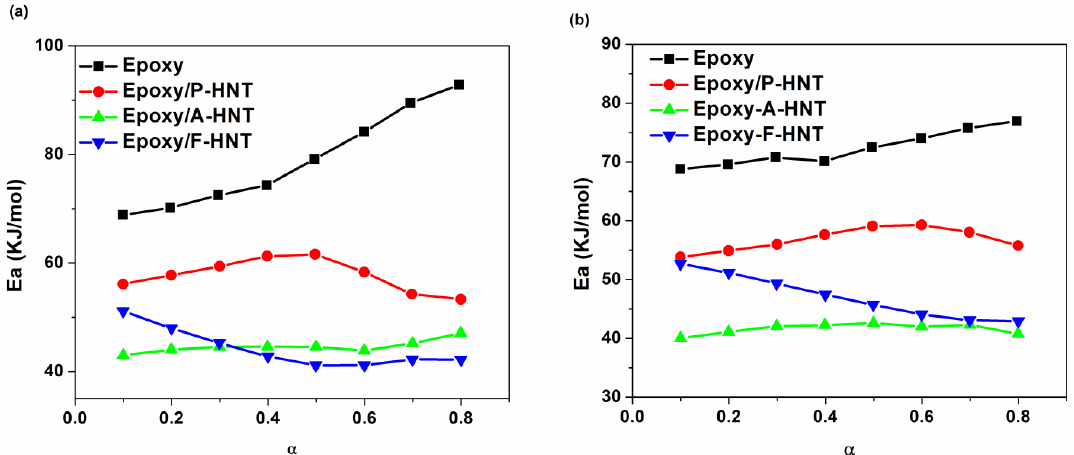
Figure 5. Variation of E α versus conversion for epoxy resin and prepared nanocomposites derived from ( a ) Friedman model and ( b ) KAS model.